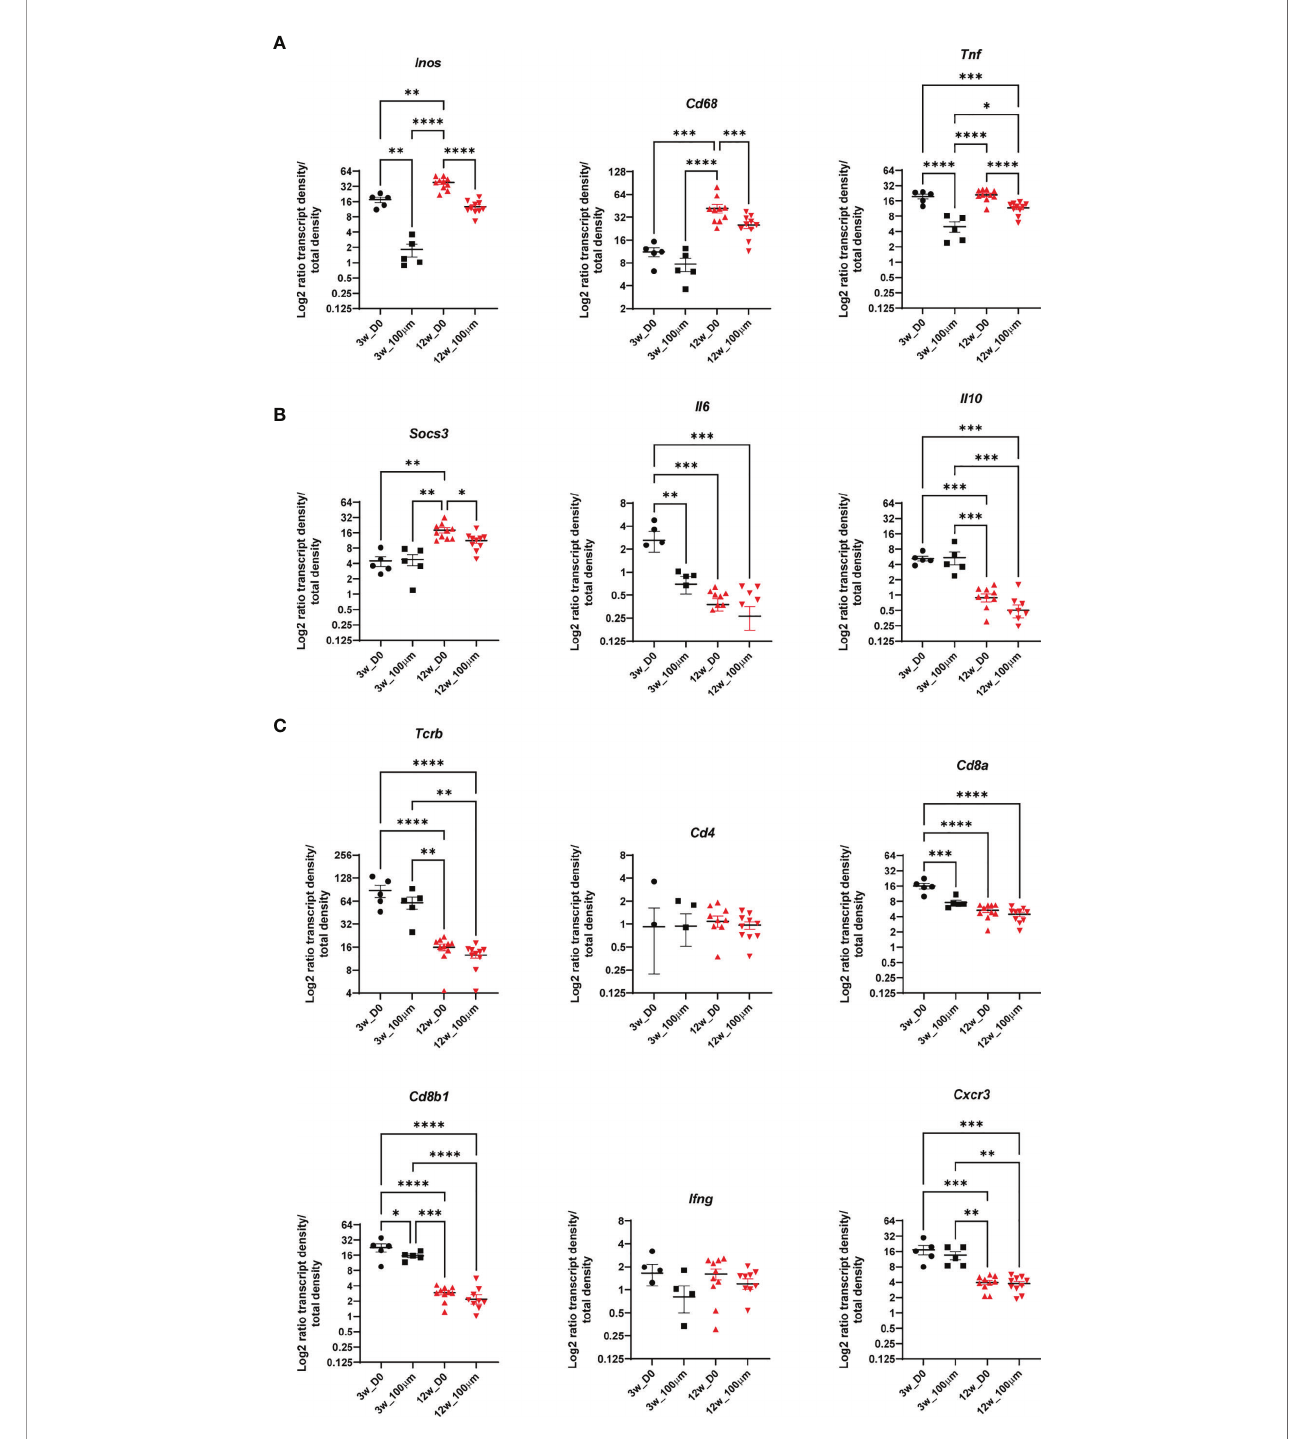
FIGURE 5 | The immune environment of bacteria clusters and bacteria cluster surrounding areas in C57BL/6 mice. Comparisons of density ratios for indicated transcripts from selected identi fi ed bacteria clusters (d0) are displayed with the addition of density ratios of the 100- m m surrounding (d100) of the bacteria clusters for one representative C57BL/6 lung section at 3 (black) and 12 (red) wpi. Transcript density ratios are displayed (A) Inos , Cd68 and Tnf ; (B) Socs3, Il6 , and Il10 cytokines; and (C) Tcrb , Cd4 , Cd8a , Cd8b1 , Ifng , and Cxcr3 . Mean density ratios ± SEM and individual values are shown, and signi fi cant differences are indicated (ANOVA, * for p < 0.05, ** for p < 0.01, *** for p < 0.001, and **** for p <